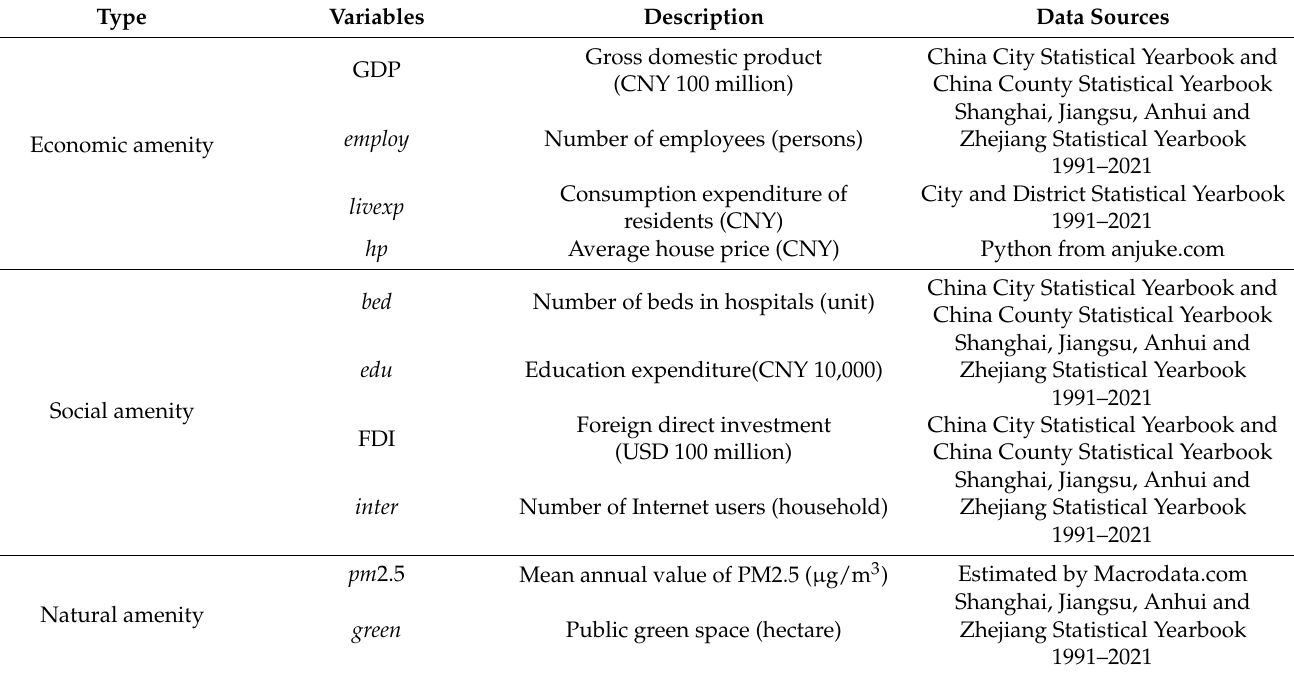
Table 1. List of